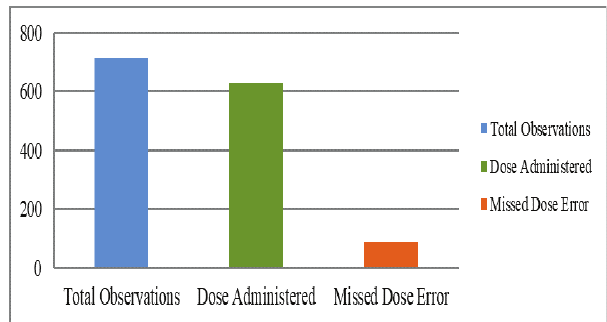
Figure-I: Missed Dose Error. Figure-II highlights the frequency of missed doses and